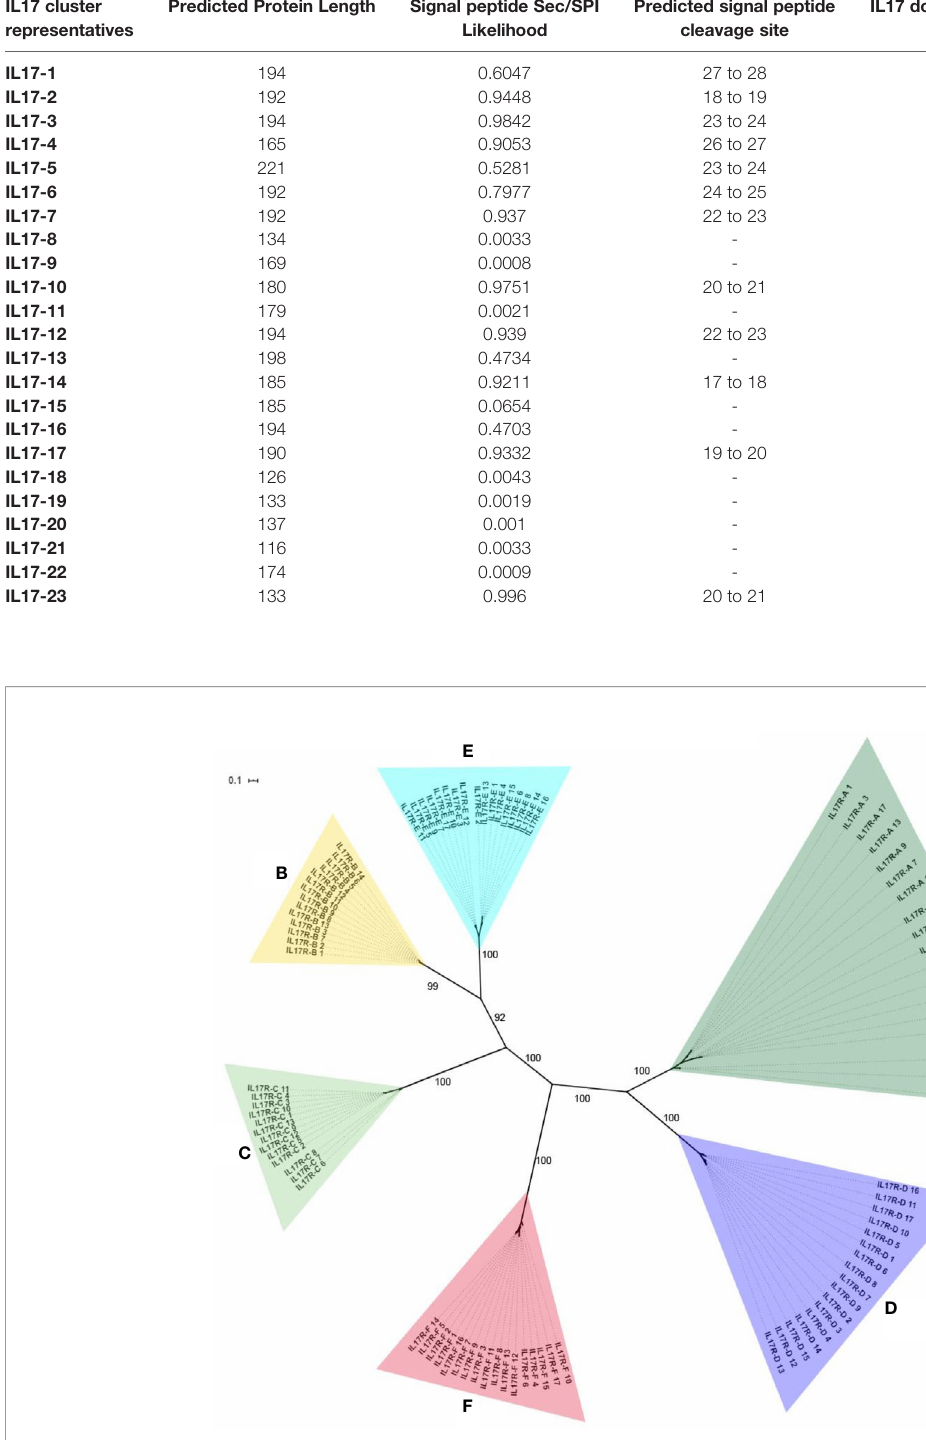
FIGURE 2 | Phylogenetic analysis of the 96 unique IL-17R sequences obtained from the 16 mussel genomes. The 96 unique IL-17R sequences retrieved from 16 mussel genomes were submitted to phylogenetic analysis with Bayesian phylogenetic inference using the GTR+G evolution model. The 6 different IL-17 clusters or isoforms obtained are indicated. The fi gure shows branch posterior probabilities.